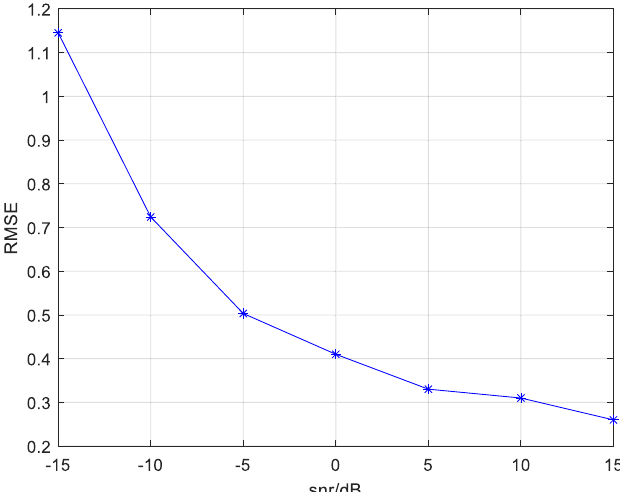
Fig. 6. Root mean square error curve under different signal-to- noise ratio.